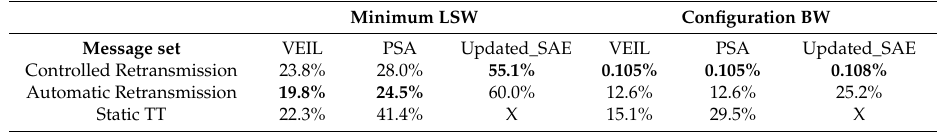
Table 6. Comparison of minimum LSW and bandwidth (BW) requirement with different design